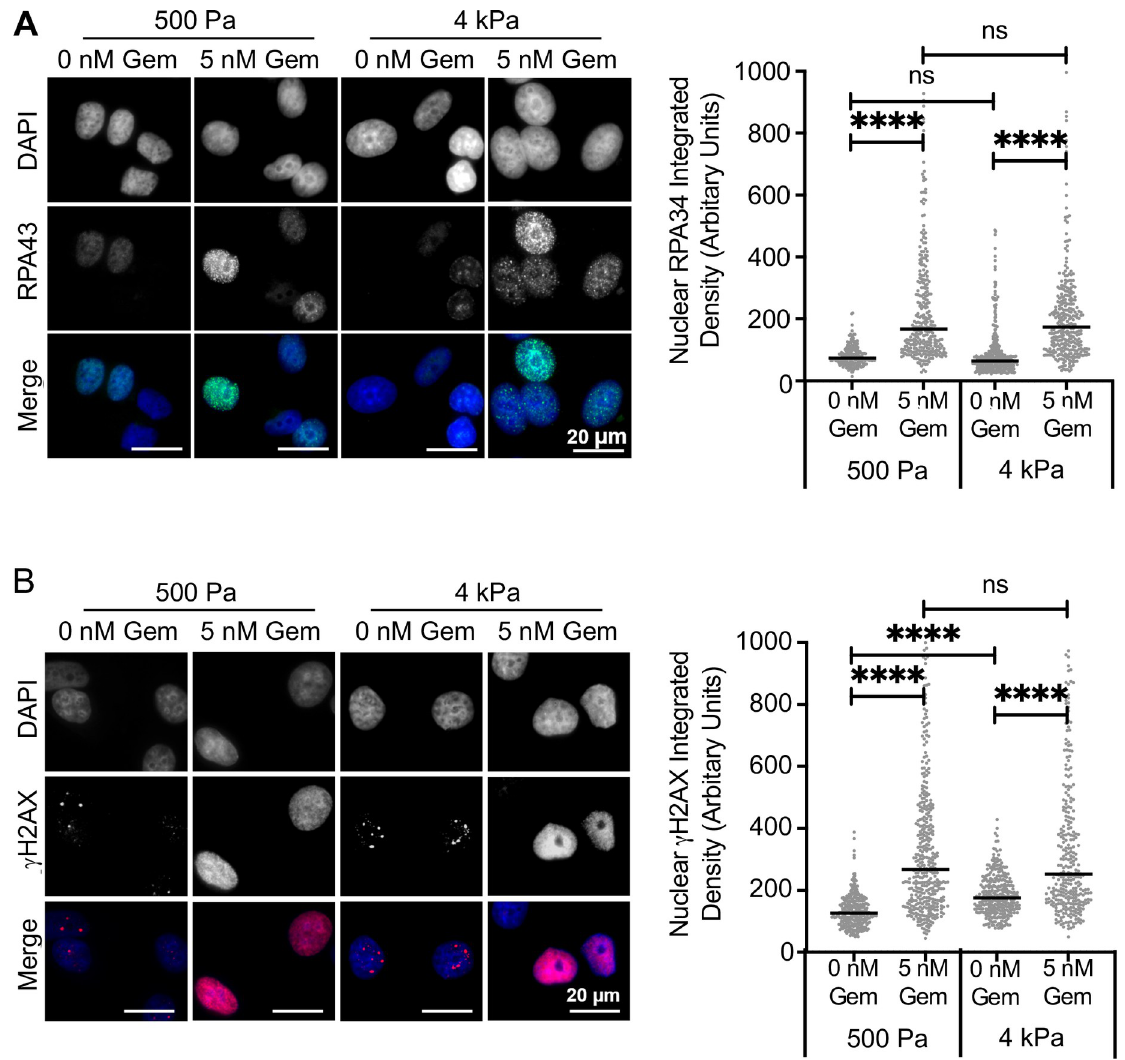
Fig 3. Stiffness specific gemcitabine resistance is not associated with altered levels of replication stress or DNA damage levels. The MCF-7 cell line was cultured on 500 Pa and 4 kPa stiffness hydrogels for 24 hrs prior to treatment with 5 nM gemcitabine (Gem) or a vehicle control for a further 24 hrs. Cells were then fixed and stained using immunofluorescence for (A) RPA34 or (B) γ H2AX. Representative images are shown for each stain. Nuclear intensity (integrated density) was measured in 100 nuclei for each of 3 independent repeats. The median and pooled data from the repeats are shown. Statistical significance was calculated using a Kruskal-Wallis test.